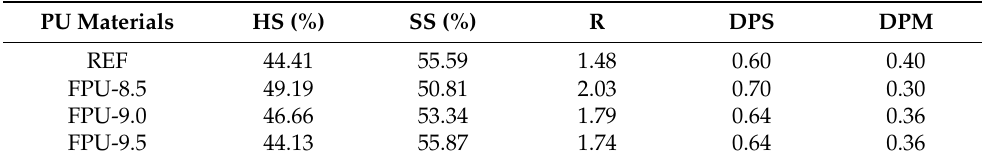
Table 2. The values of hydrogen bond index (R), degree of phase separation (DPS), degree of phase mixing (DPM), and hard (HS) and soft (SS) segment contents of the polyurethanes.